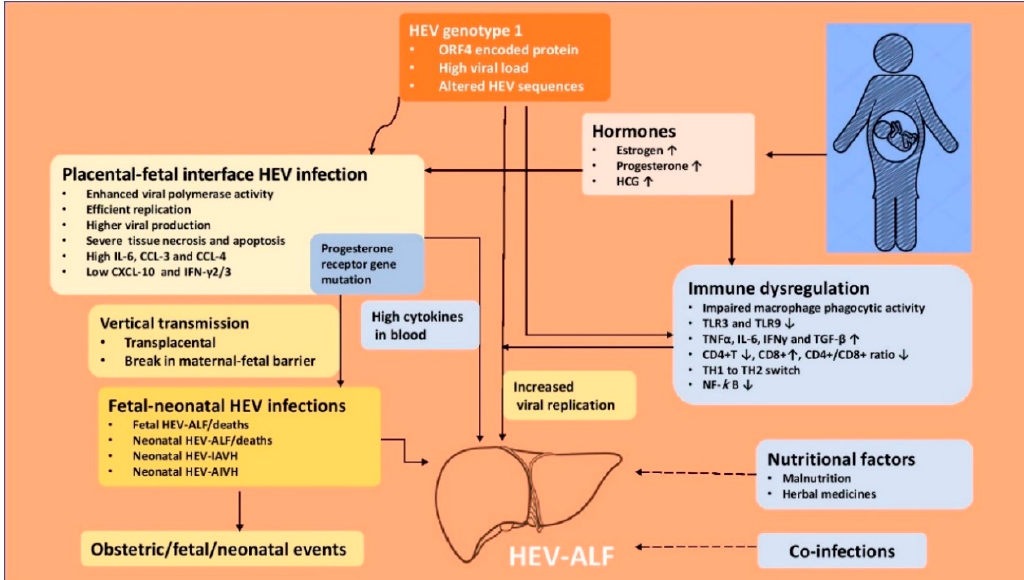
Figure 3. Pathogenesis of hepatitis E virus-related acute liver failure in pregnancy. IAVH = icteric acute viral hepatitis, AIAVH = Anicteric acute viral hepatitis, HEV-ALF = Hepatitis E virus related acute liver failure.